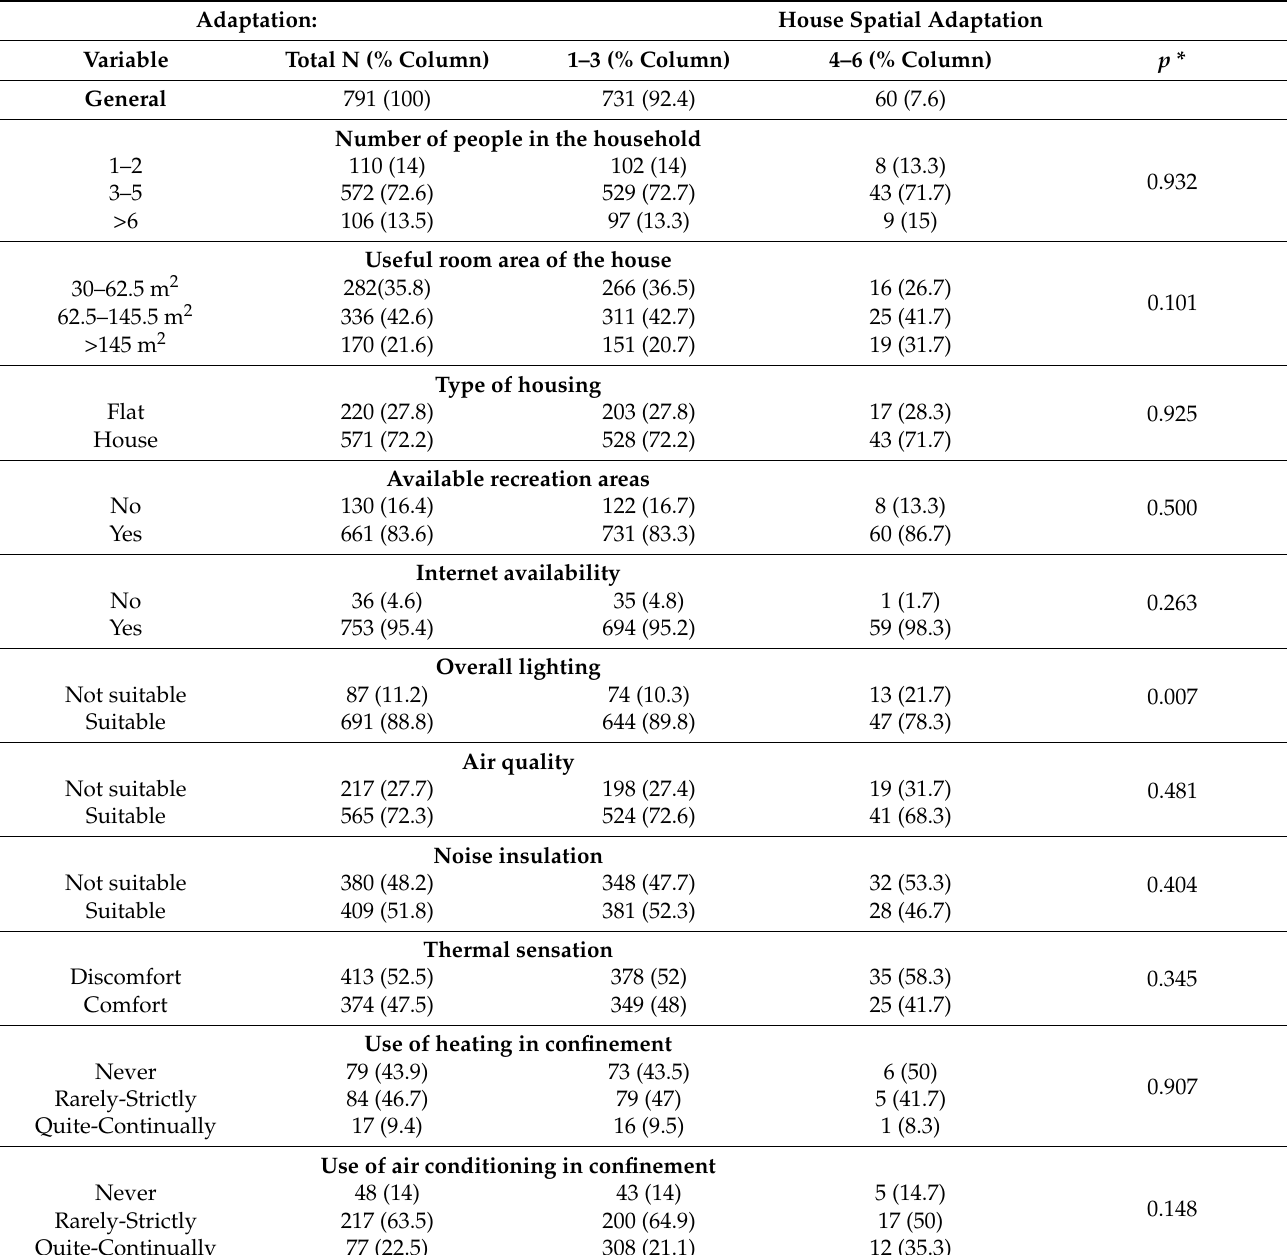
Table 5. Potential relationships among home features and